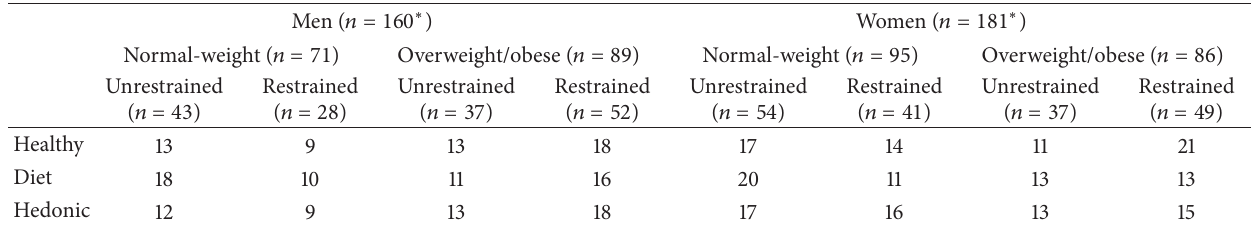
Table 1: Factorial distribution of participants ( 𝑛